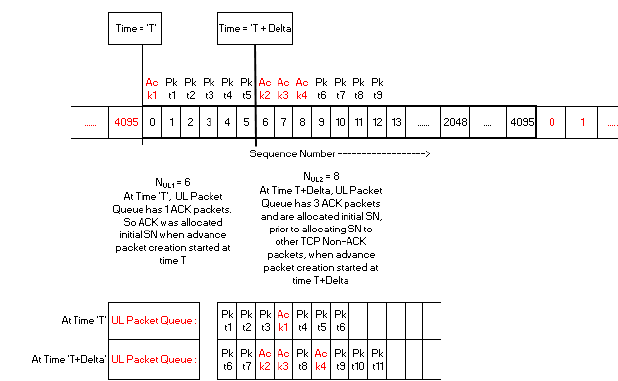
Figure 3. Reserve SN with advance packet